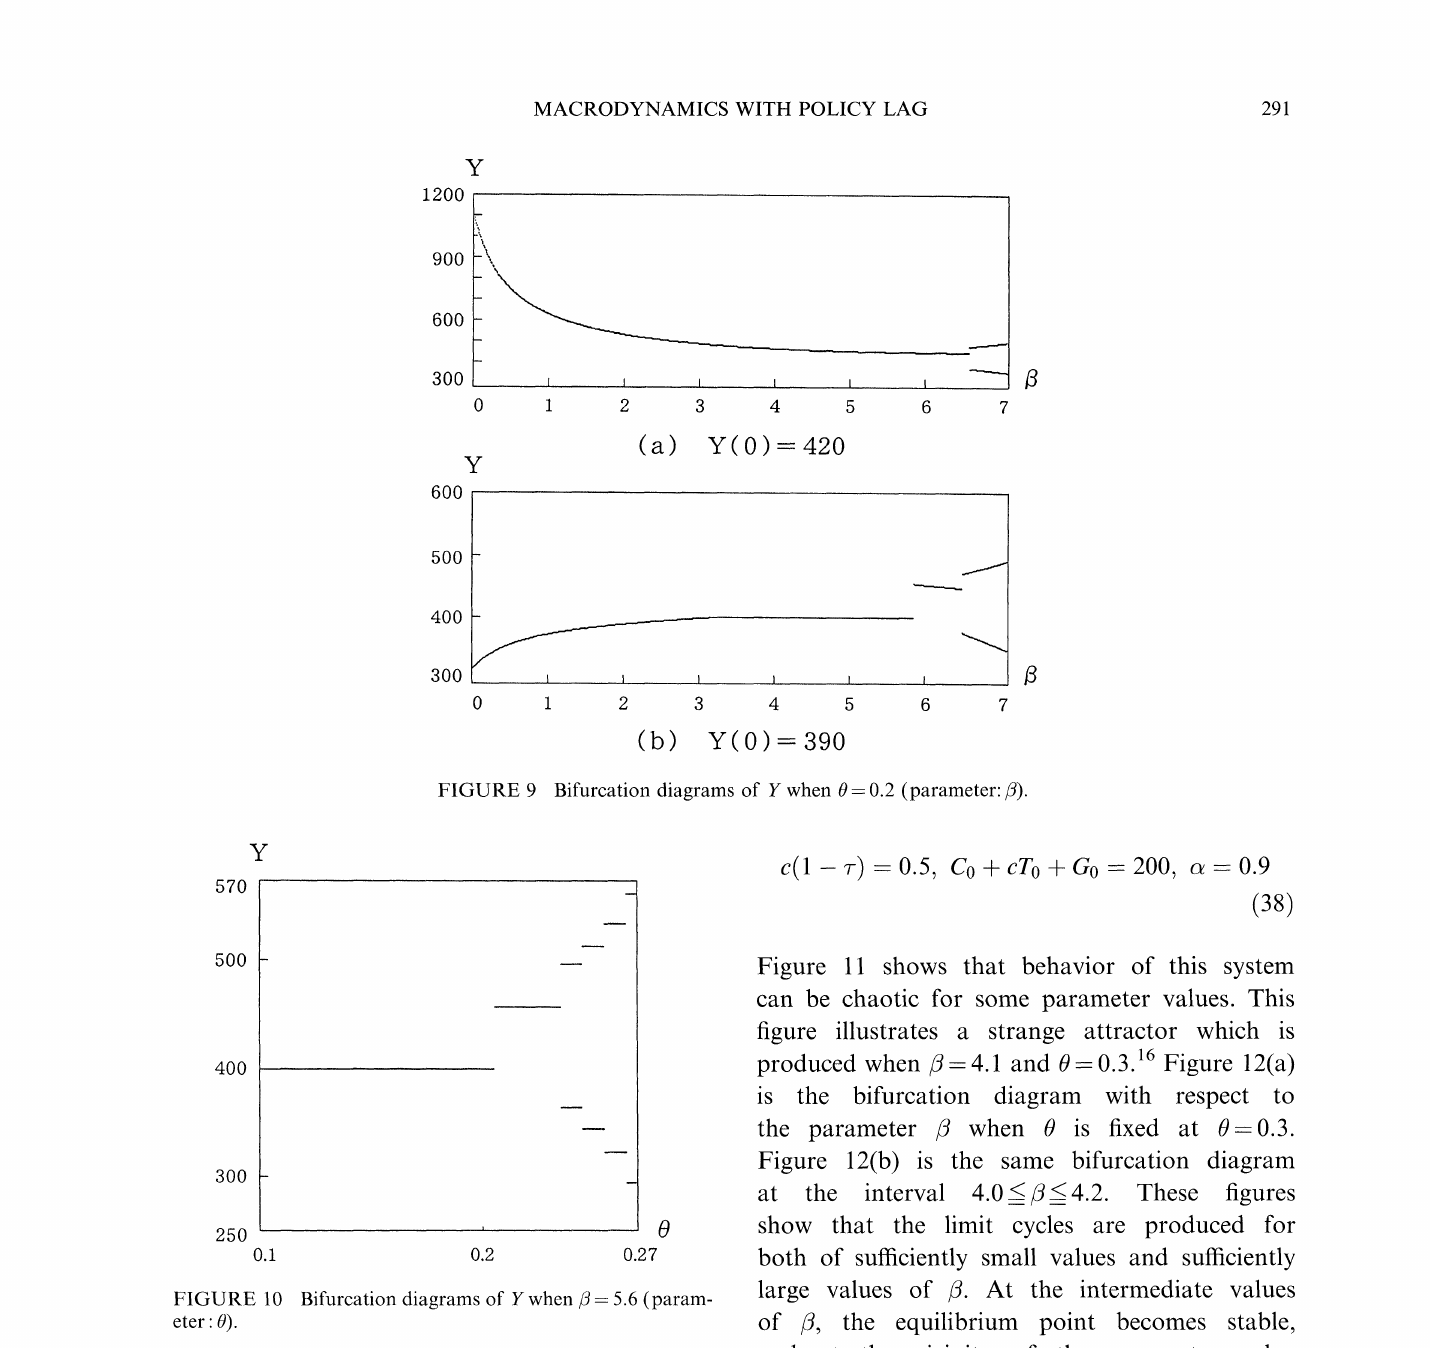
FIGURE 10 Bifurcation diagrams of Y when/3 5.6 (param-